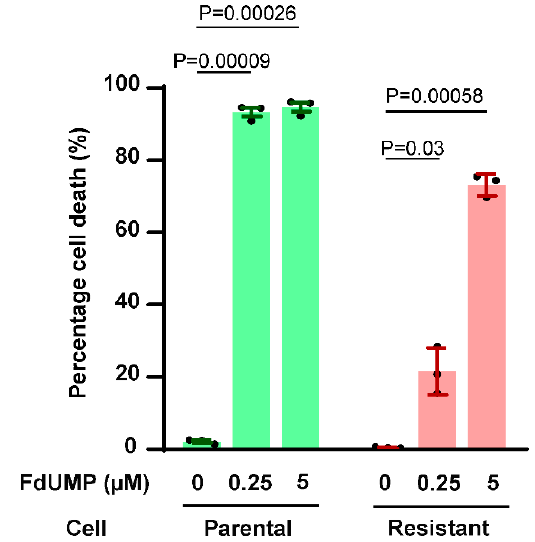
Figure 7. Resistant cells are sensitive to active metabolite FdUMP.